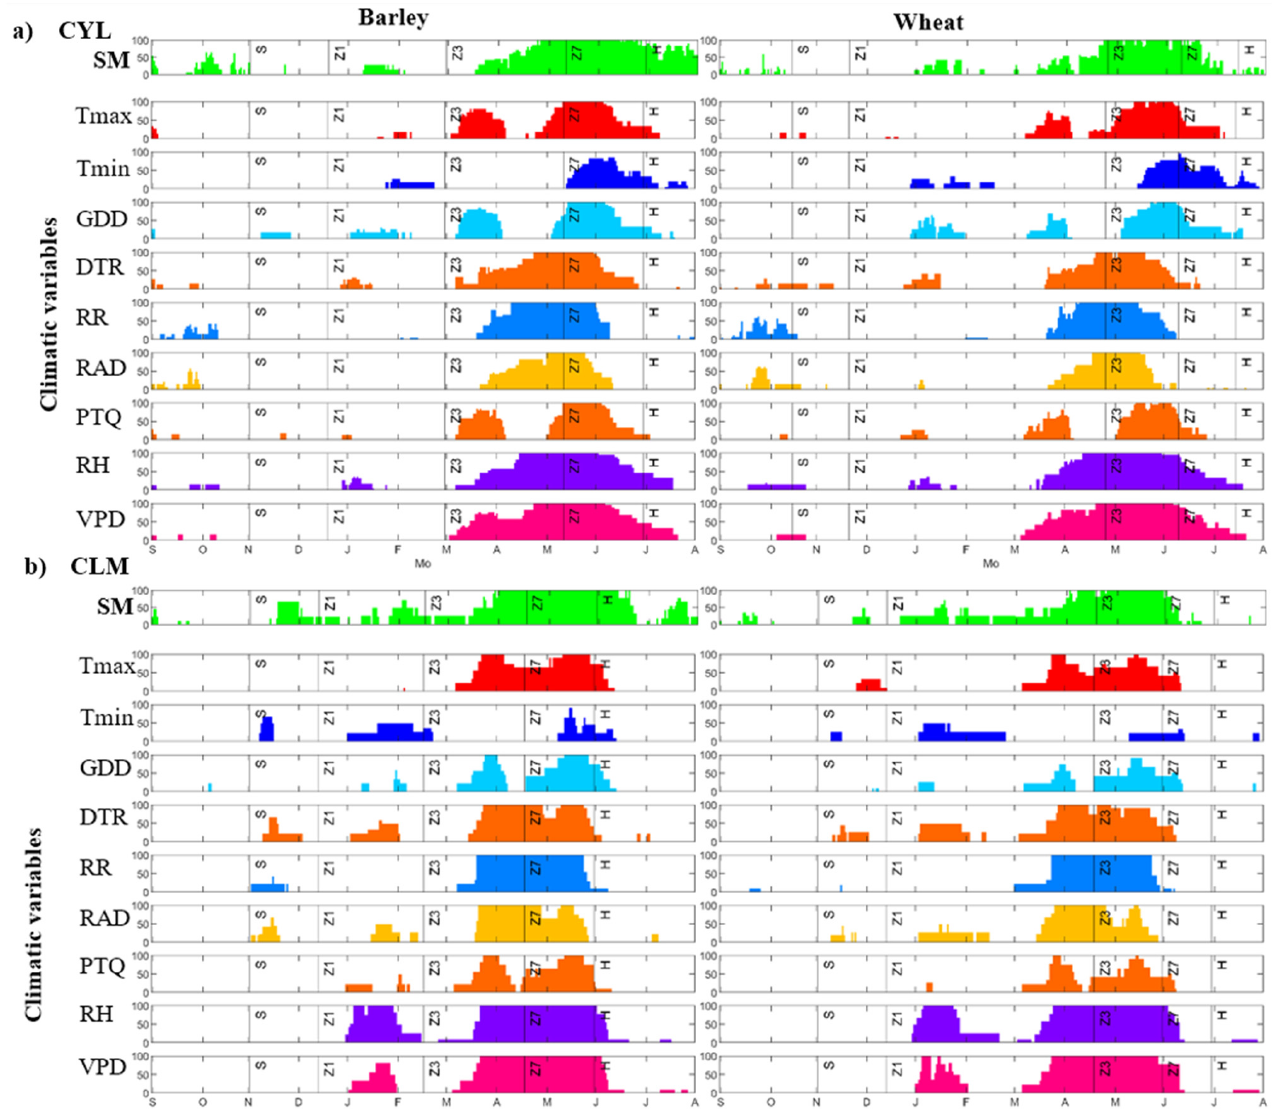
Figure 7. Synchrony of the influence of soil moisture (ERA5-Land) and climatic variables during the crop cycle. Y-axes indicate the percentage of rainfed cropland in CYL ( a ) and CLM ( b ) daily, affected by significant (absolute value) correlations of soil moisture and climatic variables on wheat (left column) and barley (right column). Months are indicated on the primary x-axis and Zadok’s stages over the vertical lines from the secondary x-axis.